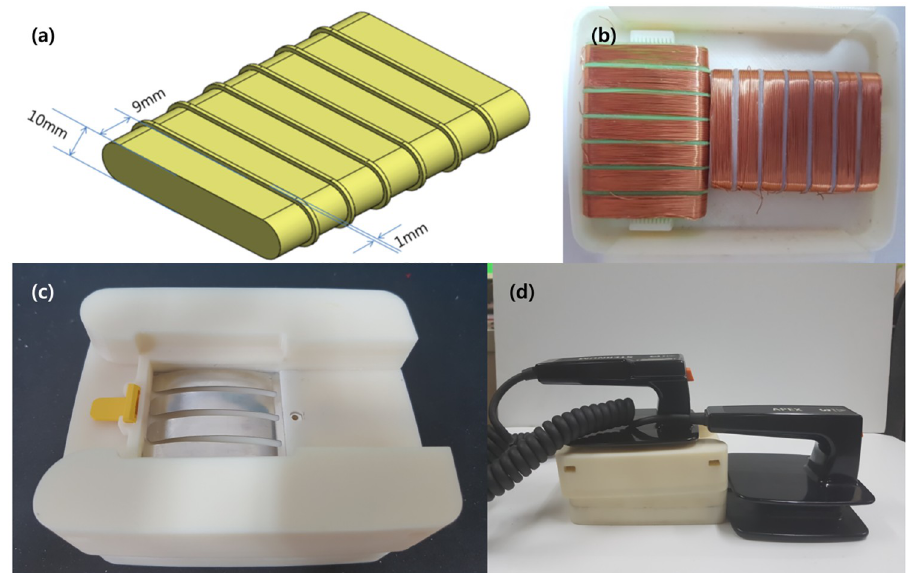
Fig 5. Paddle assembly for position measurement system. (a) Dimension of transmitting coil’s bobbin (b) assemble coil bobbin set into paddle box (c) assemble parts into complete part for position measurement system (d) assemble developed paddle parts substituting electrode plate of